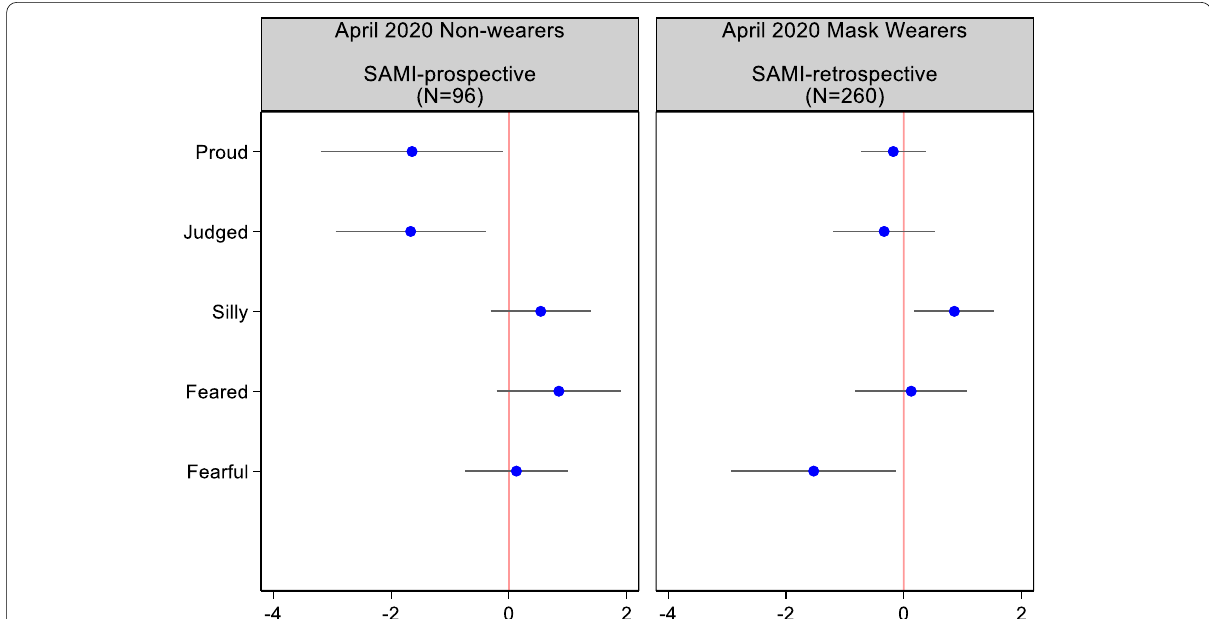
Fig. 2 Effects of SAMI appraisals on casting a vote for Donald Trump in the November 2020 election (logistic regression coefficients; restricted to respondents who did not vote for a major party candidate in